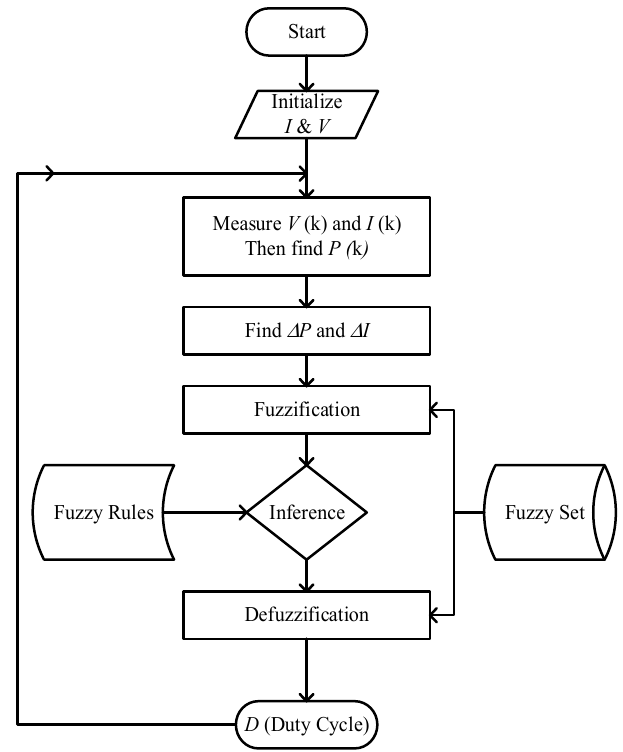
Figure 3. Fuzzy logic maximum power point tracking (MPPT) flow chart.